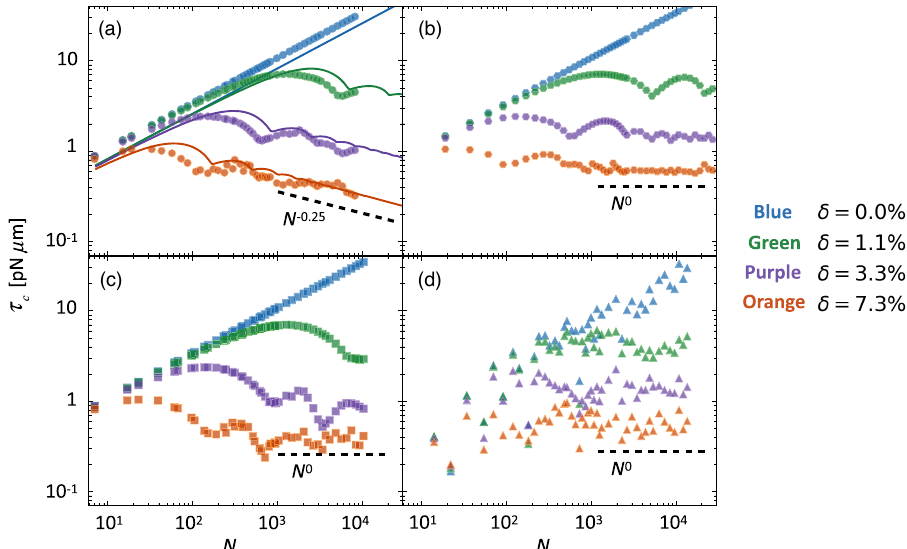
FIG. 5. The static torque τ as a function of cluster size N evaluated numerically from the microscopic model (data points) at different c mismatch ratio δ . Panels (a) – (d) correspond to circular-, hexagonal-, square-, and triangular-shaped clusters, respectively. In each panel, the four sets of data (from above to below) correspond to δ ¼ 0 . 0% , 1.1%, 3.3%, 7.3%, respectively (also specified by different colors as ∝ N 0 is observed at large N for all shapes except for the circular clusters in (a) where a τ reported in the legend). A scaling τ c relation is observed, in agreement with the corresponding curves of the coarse-grained model (solid